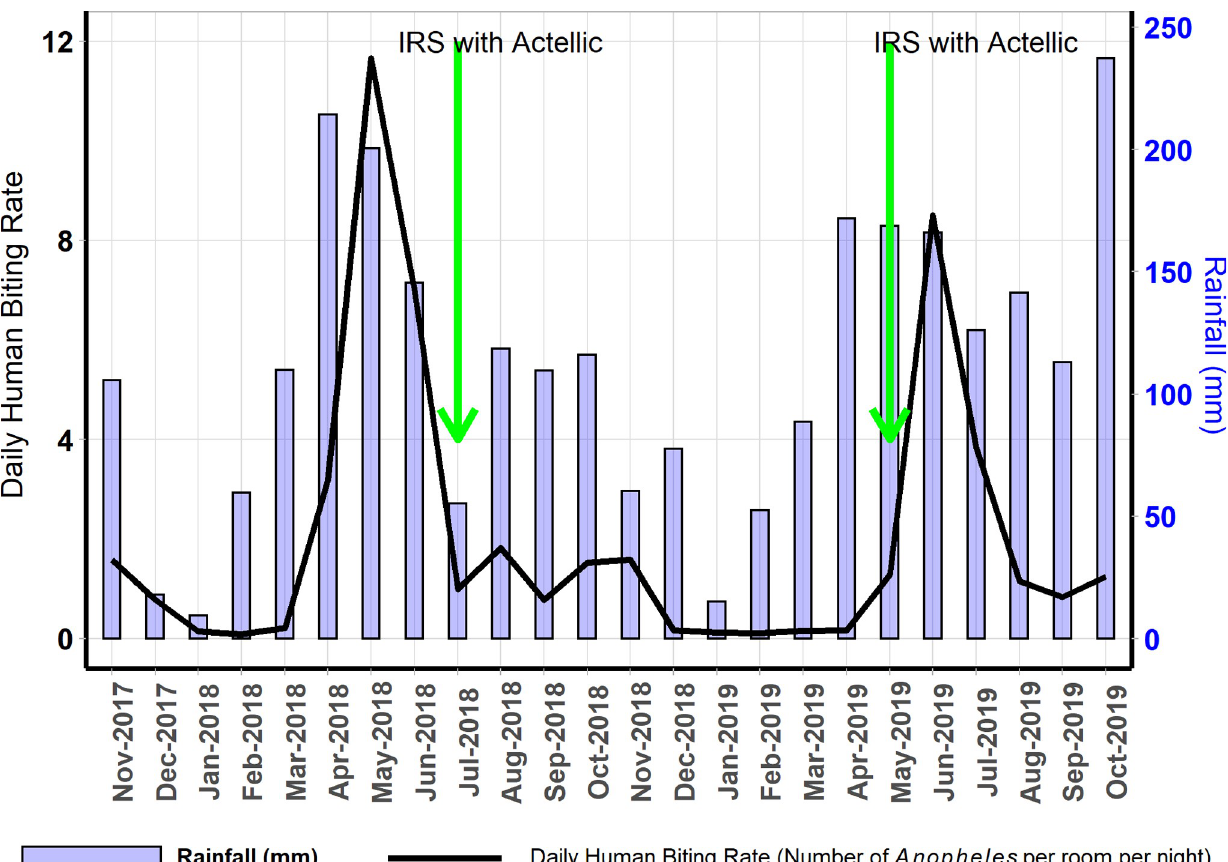
Fig 3. Mean daily human biting rate by month, in relation to two indoor residual spraying campaigns with Actellic and mean monthly rainfall estimated for Nagongera sub-county using the National Aeronautics and Space Administration Tropical Rainfall Measuring Mission [29]. Peak biting rates correspond with higher